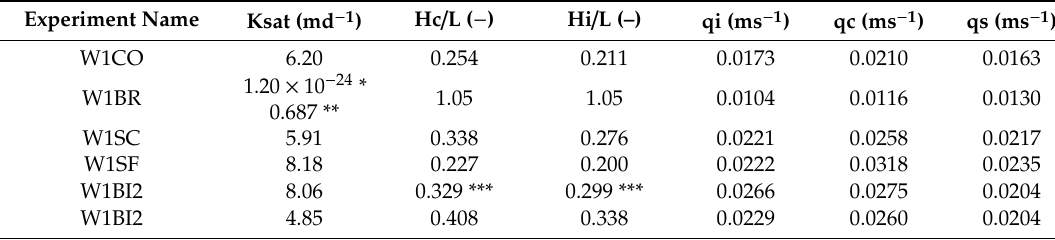
Table 2. Hydraulic head gradients and associated flow velocities through the outlet for initiation, critical gradient, and the calculated velocity required to a grain out of the outflow point for backward erosion initiation through Stokes’ Law. Here Hc / L and Hi / L are the critical gradient and the initiation gradient for erosion respectively. Respectively, qi, qc and qs are the flow velocities in the outflow point for initiation, critical and calculated flow velocities for initiation through Stokes’ law (applied to di ff erent grain sizes). * parameter ‘a’ in the Forchheimer formula. ** parameter ‘b’ in the Forchheimer formula. *** Forward